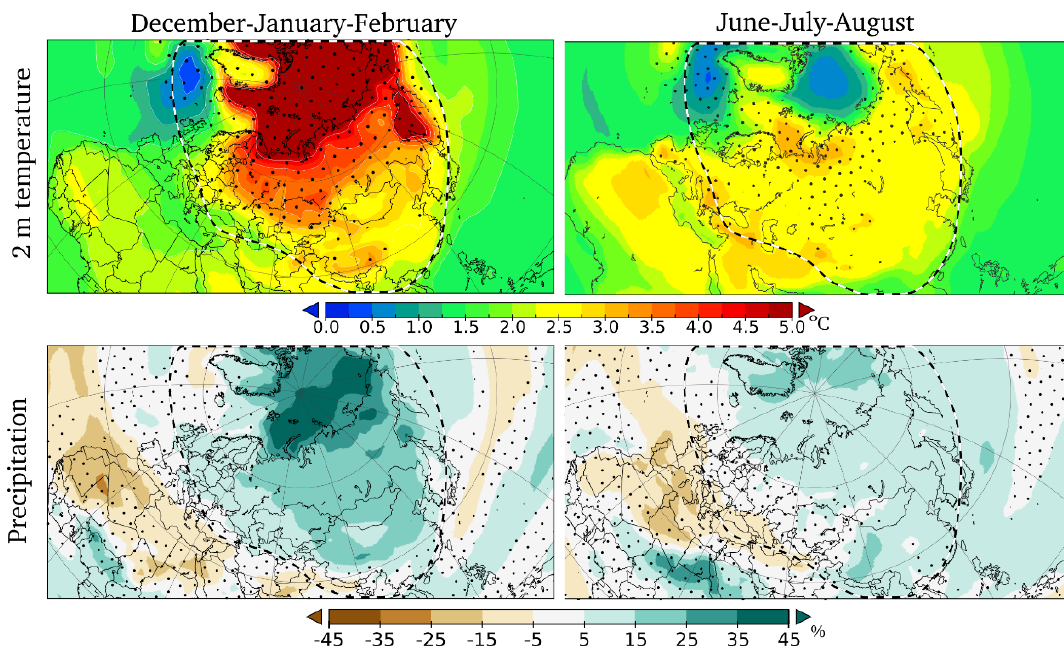
Figure 9. Changes in 2m temperature ( ◦ C, upper panels) and precipitation (%, lower panels) during the 21st century. Present-day climatology is averaged over the years 1981–2010 and end-of-century climatology over 2070–2099. Winter (left) and summer (right) are shown separately. Dotted areas indicate high variability in the model ensemble (for temperature: standard deviation of 21st century change exceeds 1 ◦ C; for precipitation: standard deviation of 21st century change exceeds 100% or present-day precipitation). The model results are from IPCC AR5, based on 42 individual models in CMIP5 experiments under the RCP4.5